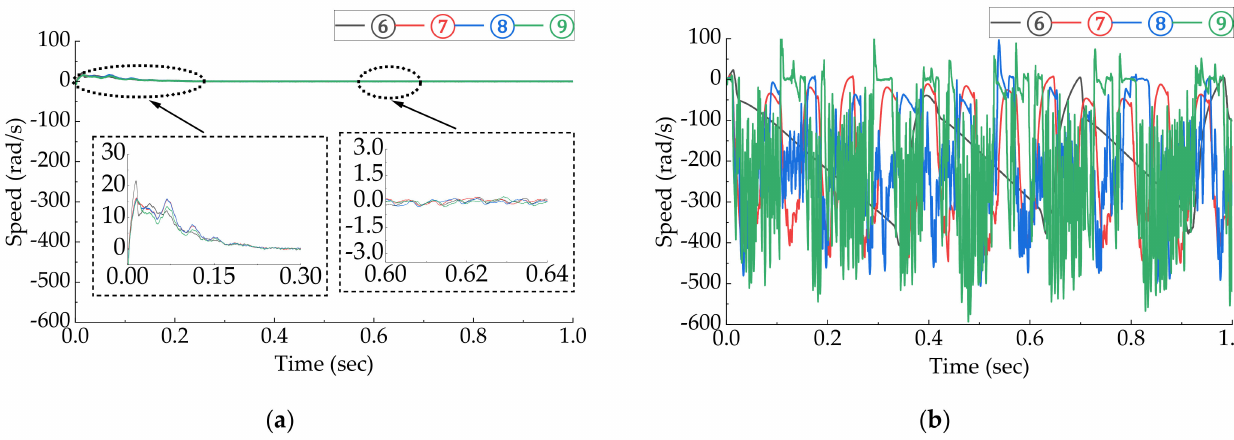
Figure 6. ( a ) When the Q value is 6 (cid:13) – 9 (cid:13) , the difference between actual speed and estimated speed based on PAEKF. ( b ) When the Q value is 6 (cid:13) – 9 (cid:13) , the difference between actual speed and estimated speed based on